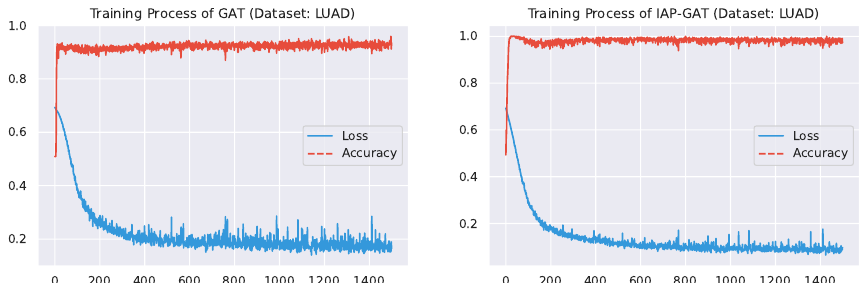
Figure A4. Training process of GAT and IAP-GAT on LUAD dataset.